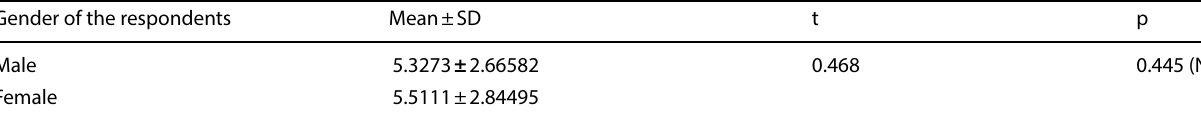
Table 4 One-way independent t-test of difficulties experienced by older adults when not using assistive devices by gender